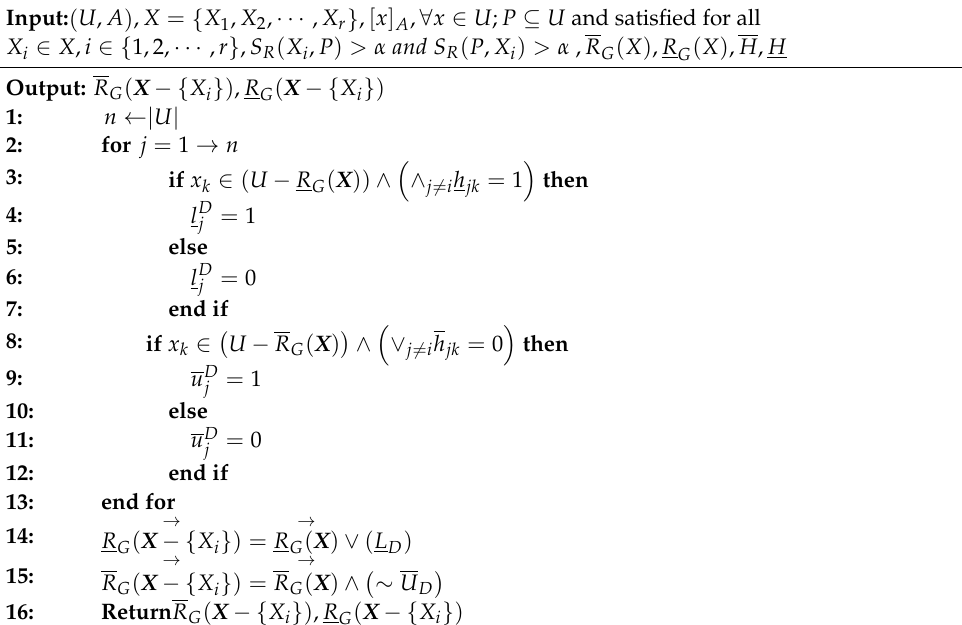
Algorithm 3. Dynamic Computing Approximations of a GMTRS while Removing a Target